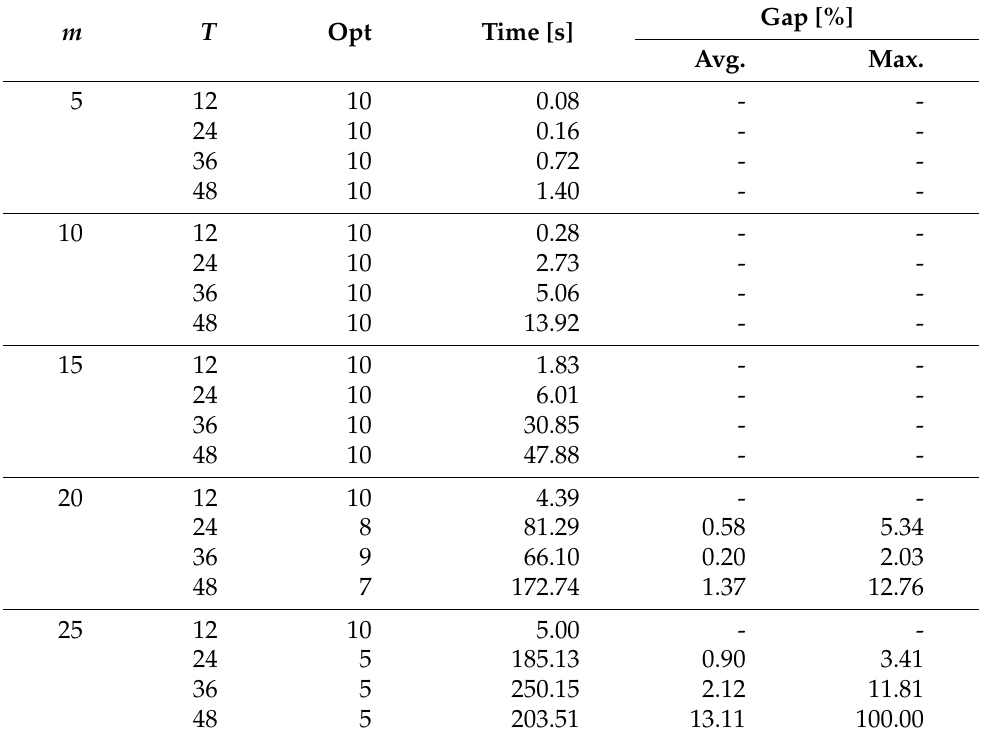
Table 3. Results of computational